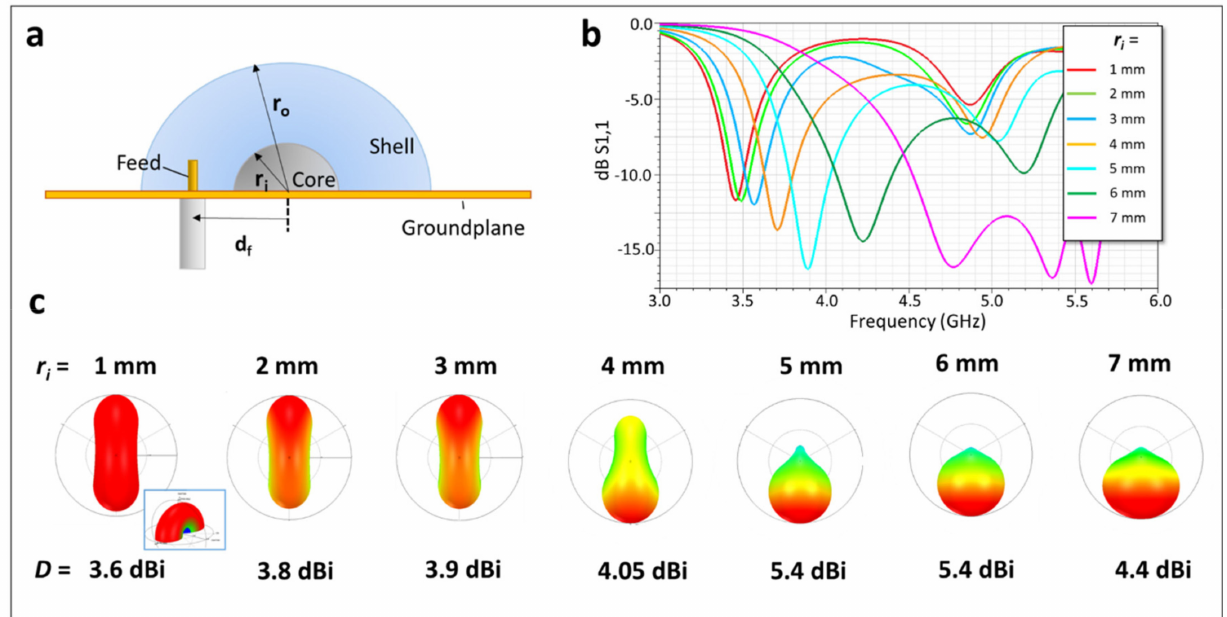
Figure 5. ( a ) A design for a unidirectional hemispherical dielectric resonator antenna based on mode stacking. The hemisphere has a 12.5 mm radius with a permittivity ε = 10.5 and a metallic core with a radius r i . The feed consists of a 6 mm long, 1.3 mm diameter feed probe cut from a PTFE-filled coaxial cable with a diameter of 4.1 mm. The groundplane is an infinite PEC. ( b ) Simulated S11 values from this design as the radius of the metallic core, r i is varied. Here the probe position, is fixed at d f = 10 mm. ( c ) Directivity plots of all r i values simulated, with the maximum directivity, D shown